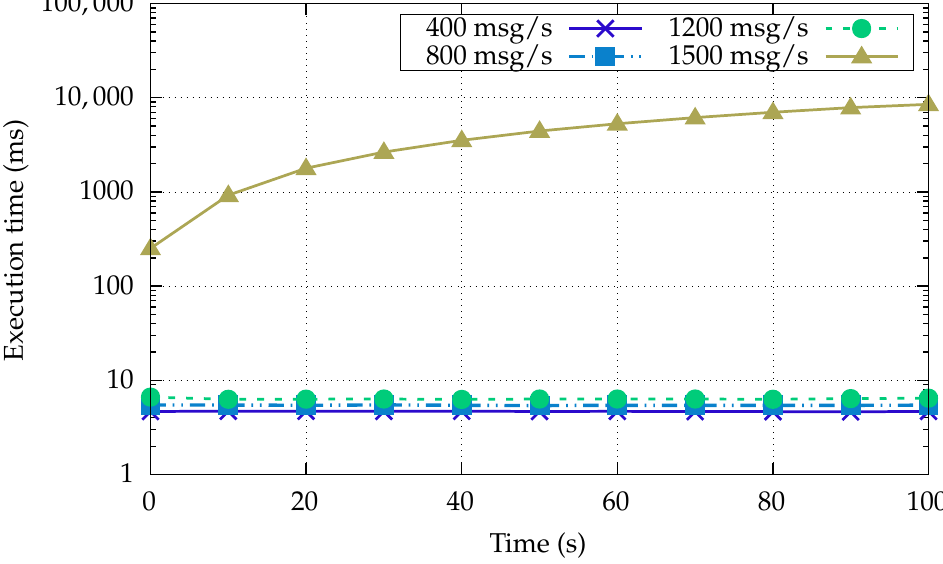
Figure 4. Machine-to-consumer communication latency under varying message load of the IT